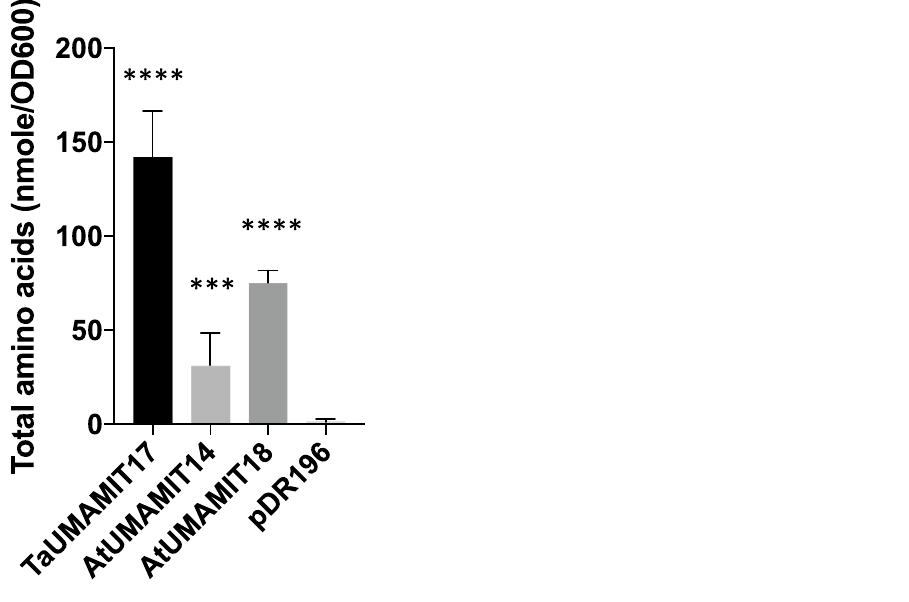
Figure 7. TaUMAMIT17 exports amino acid secretion in yeast. Amino acid secretion from 22Δ10α cells expressing TaUMAMIT17D, AtUMAMIT14 and AtUMAMIT18, compared the vector control (pDR196). Statistical difference according to Student’s t-test is shown with asterisks (n ≥